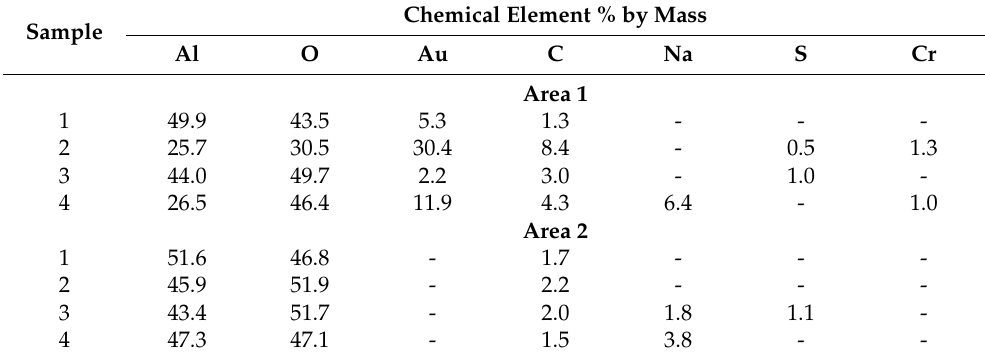
Table 3. Chemical composition shown in cross-sections of oxide layers.